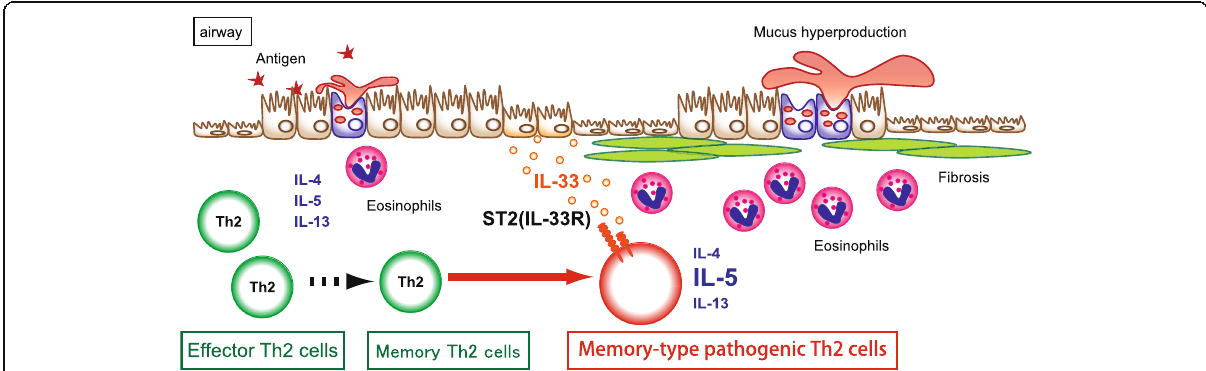
Fig. 1 Induction of memory-type pathogenic Th2 cells. IL-33 stimulation induced IL-5-producing memory-type pathogenic Th2 cells at the local inflammatory